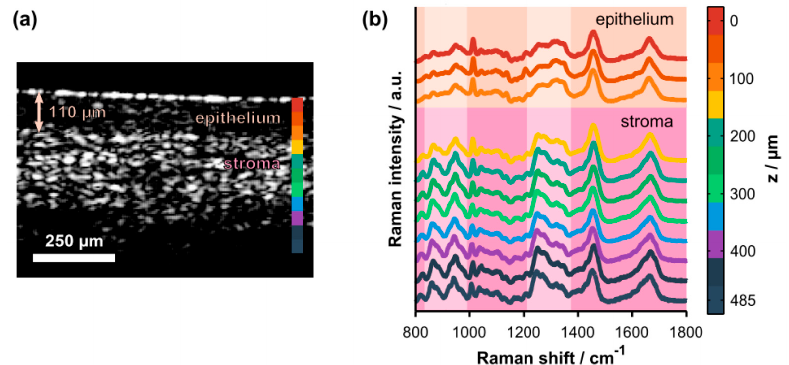
Figure 3. ( a ) Representative cross-sectional OCT image of intact, ex vivo porcine vaginal tissue. The arrow highlights the thickness of the superficial epithelium. The colorbar shows the axial locations where Raman spectra were acquired. ( b ) Co-localized, depth-resolved Raman spectra acquired from the same tissue sample (offset for clarity). Spectroscopic differences due to natural biochemical variation (e.g., collagen content) in the epithelium versus the stroma are highlighted by the pale- colored columns. The highlighted spectral regions include hydroxyproline and proline bands (800– 1000 cm − 1 ) and the amide III protein band (1200–1400 cm − 1 ). Figure reproduced with permission